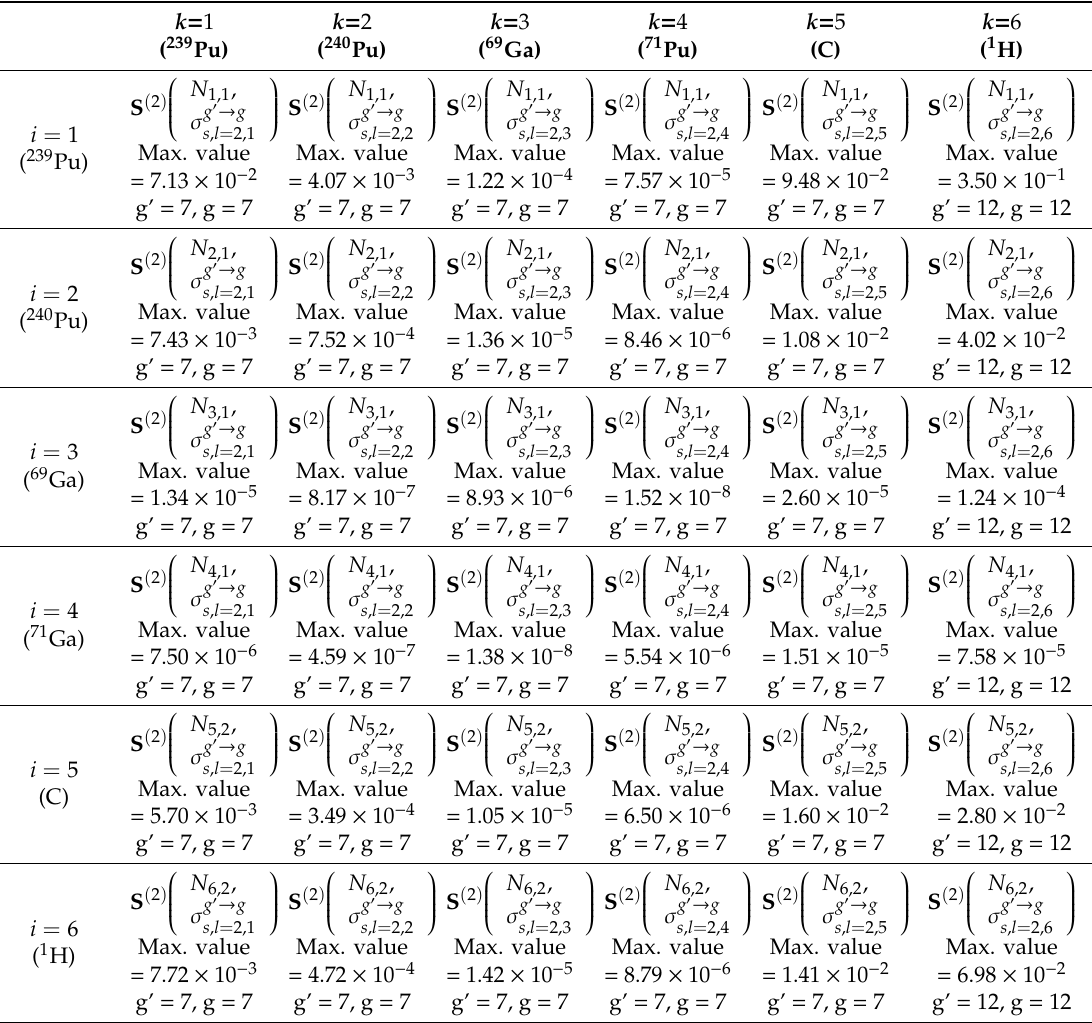
(cid:16) (cid:17) (cid:48) → g N i , m , σ g , for 2nd-order relative sensitivities of s , l = 2, k